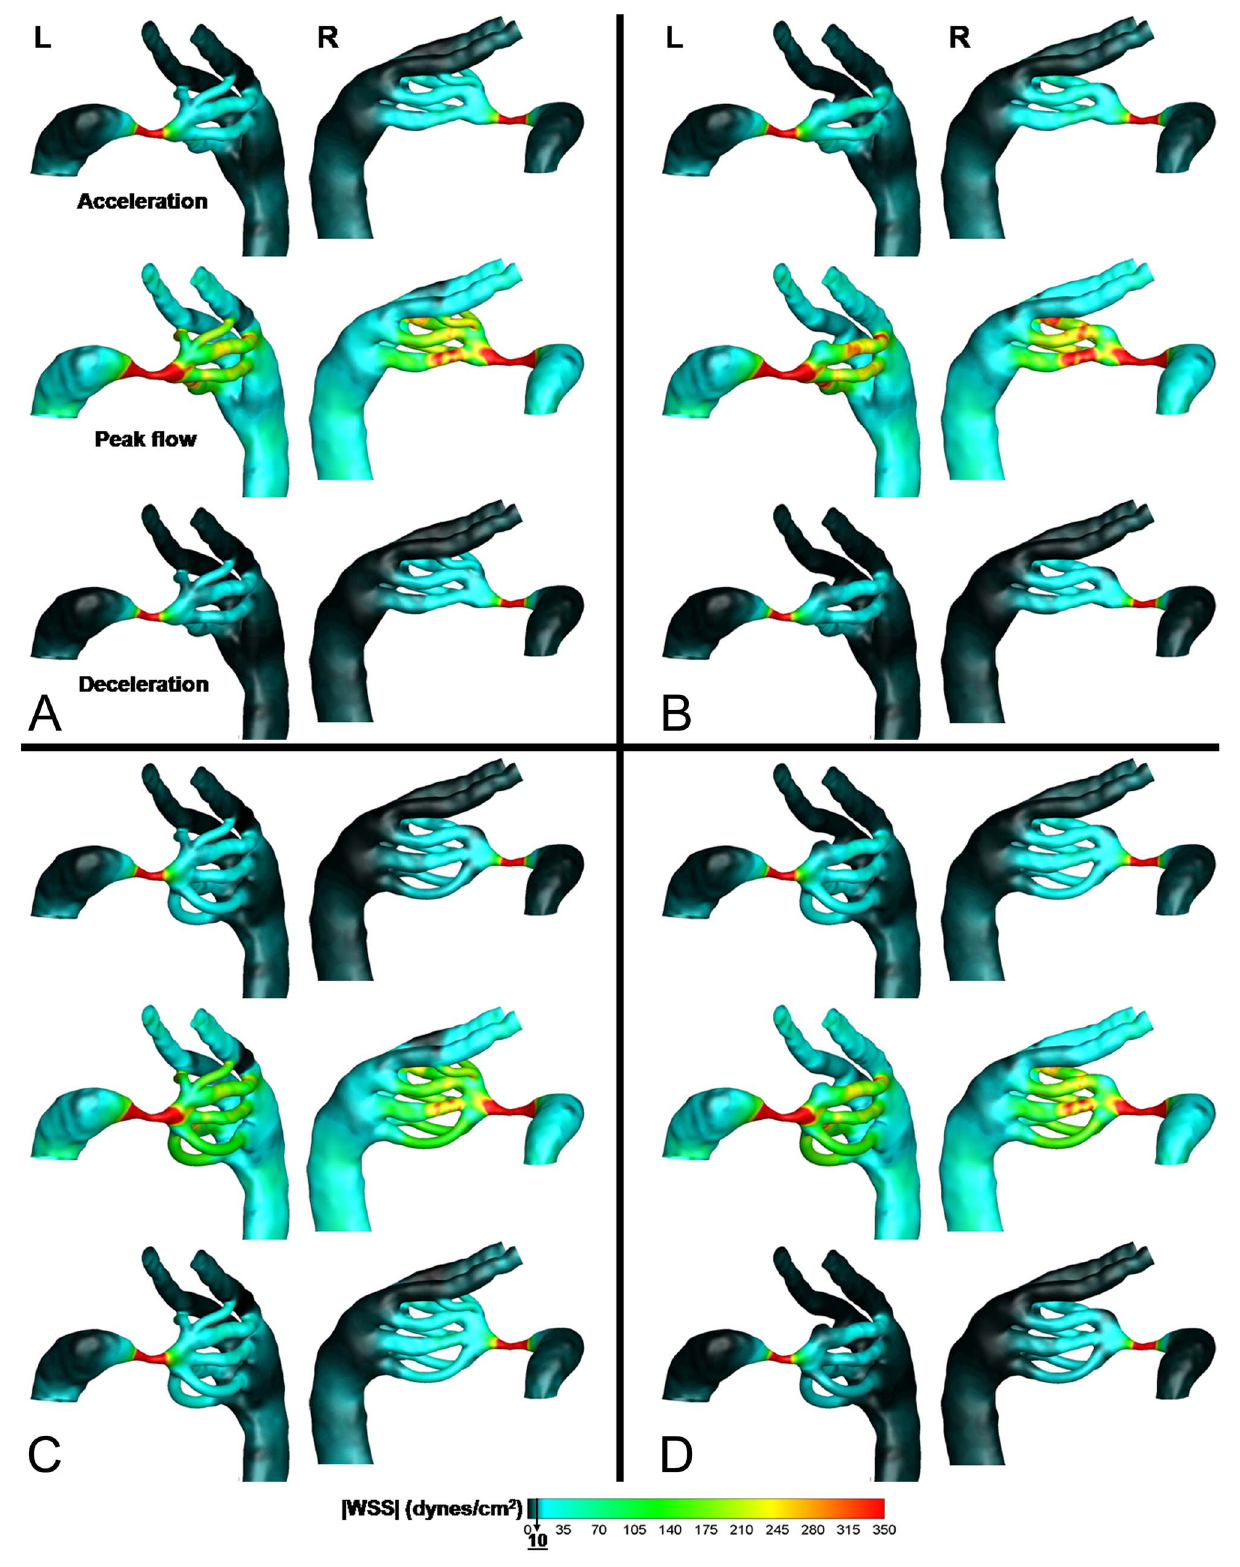
Figure 5. AA WSS distributions computed from CFD simulations for each of the four configurations observed at stage 21. Acceleration, peak, and deceleration phases of the cardiac cycle are depicted. (A) 3AA-cranial, (B) 2AA, (C) 4AA, (D) 3AA-caudal.